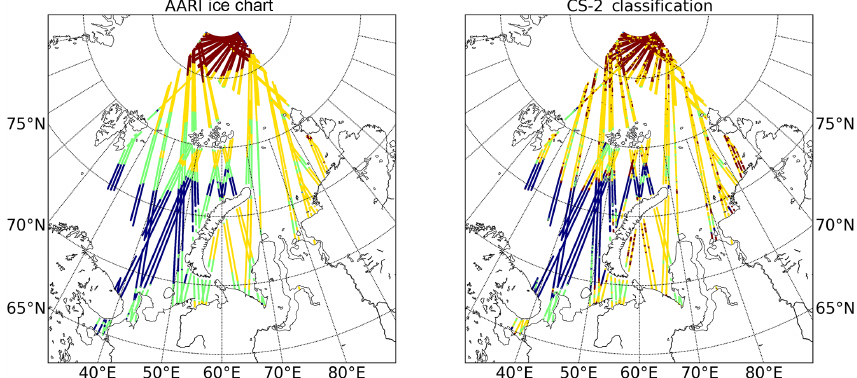
Figure 6. Automatic classification test for March 2014. AARI ice chart SA sampled at CS-2 footprints (left panel) and the classification result from CS-2 measurements (right panel). 15–30 March 2014. Blue: open ocean; green: FY < 70cm; yellow: FY > 70cm; and red: